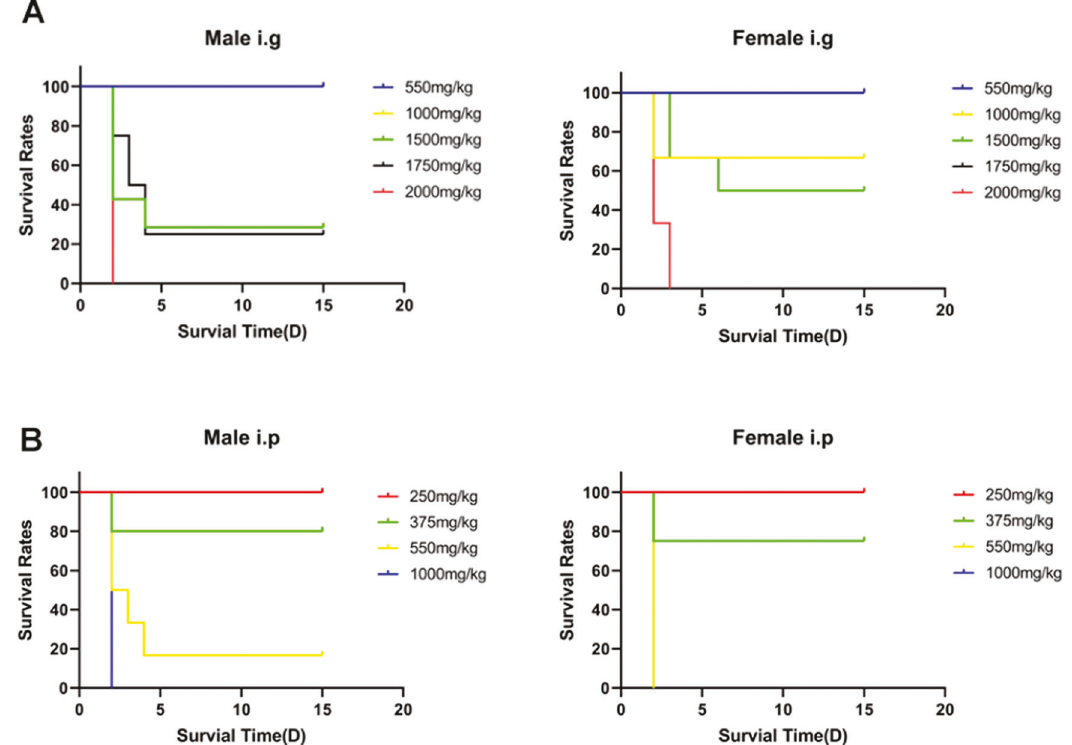
Fig. 3 Kaplan – Meier curve after I3C administration in mice. Each point on the curve represents the survival rate of the mice at that point in time. When the X-axis is 0, the follow-up has just begun, and no mice has died, so the survival rate of all groups is 100%. A Survival rates after I3C i.g. administration in male ( n = 3) and female ( n = 3) mice. B Survival rates after I3C i.p. administration in male ( n = 3) and female ( n = 3) mice. We observed that single administration of doses higher than 1000 mg/kg (i.g.) and 375 mg/kg(i.p.) to mice determined relevant mortality rate both in male and female mice. Due to the early death of some groups of mice, some group information is not shown on the Fig. (mice died within 4 h from the administration of i.g and